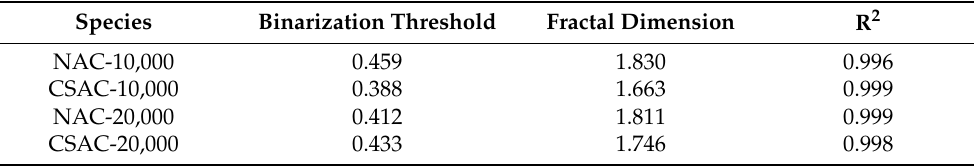
Table 12. Results of fractal